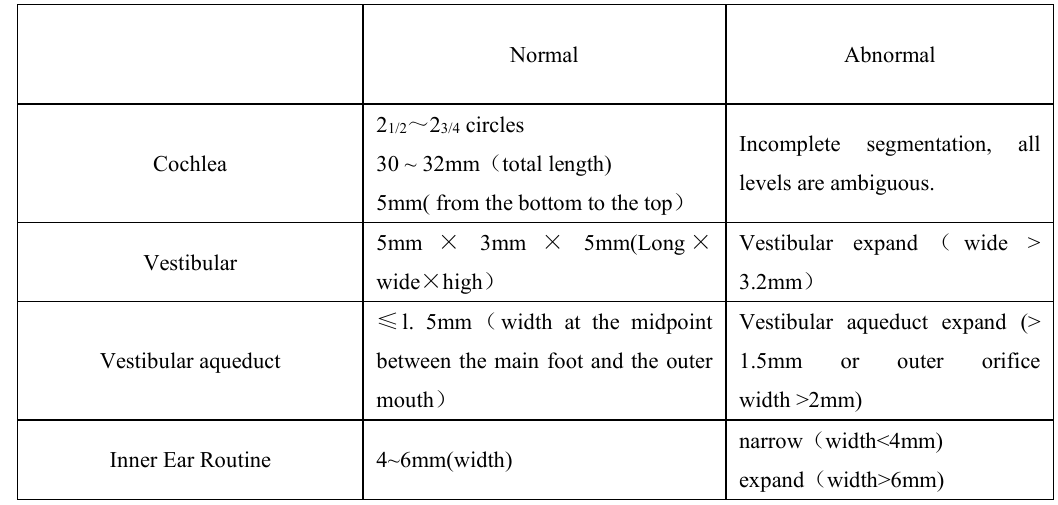
Table 2. Inner ear detection standard